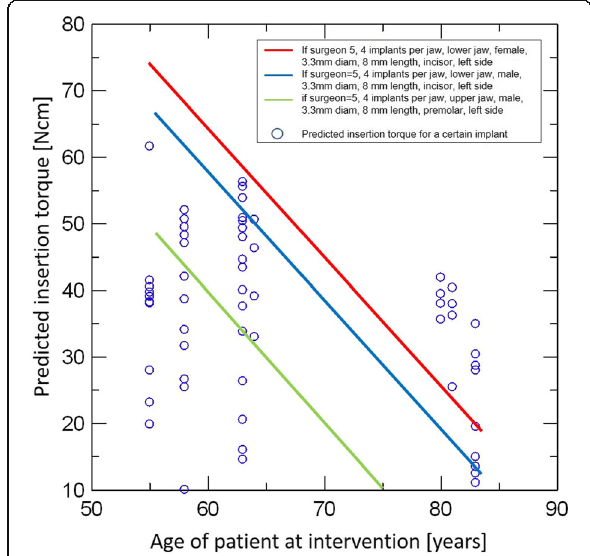
Fig. 7 Predicted insertion torque and the age of the patient at intervention. To be able to plot predicted insertion torque versus age, the predicted insertion torque was calculated at a certain value of each parameter in the same